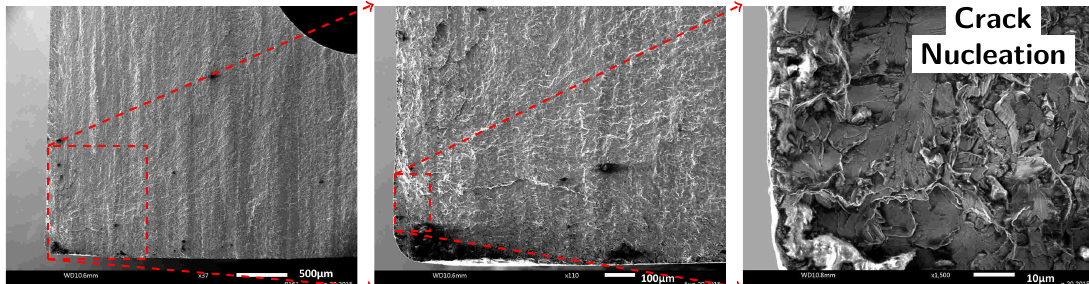
Figure 7. SEM images of the fracture surface of Specimen 4 (wrought material with capillary). The fatigue crack initiated from the bottom left corner of the beam.